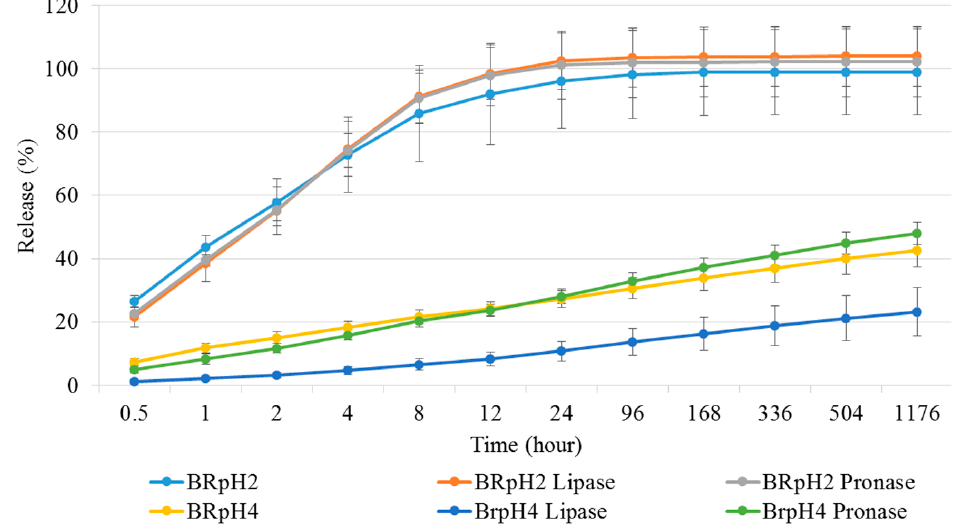
Figure 9. Presentation of cumulative amounts of released drugs in different pHs, and with different enzymes by the accumulation of the released CHX in different measuring points and the relations to the entire drug contents. Values are expressed as sample means, error bars represent the standard deviation (SD) of three parallel measurements.